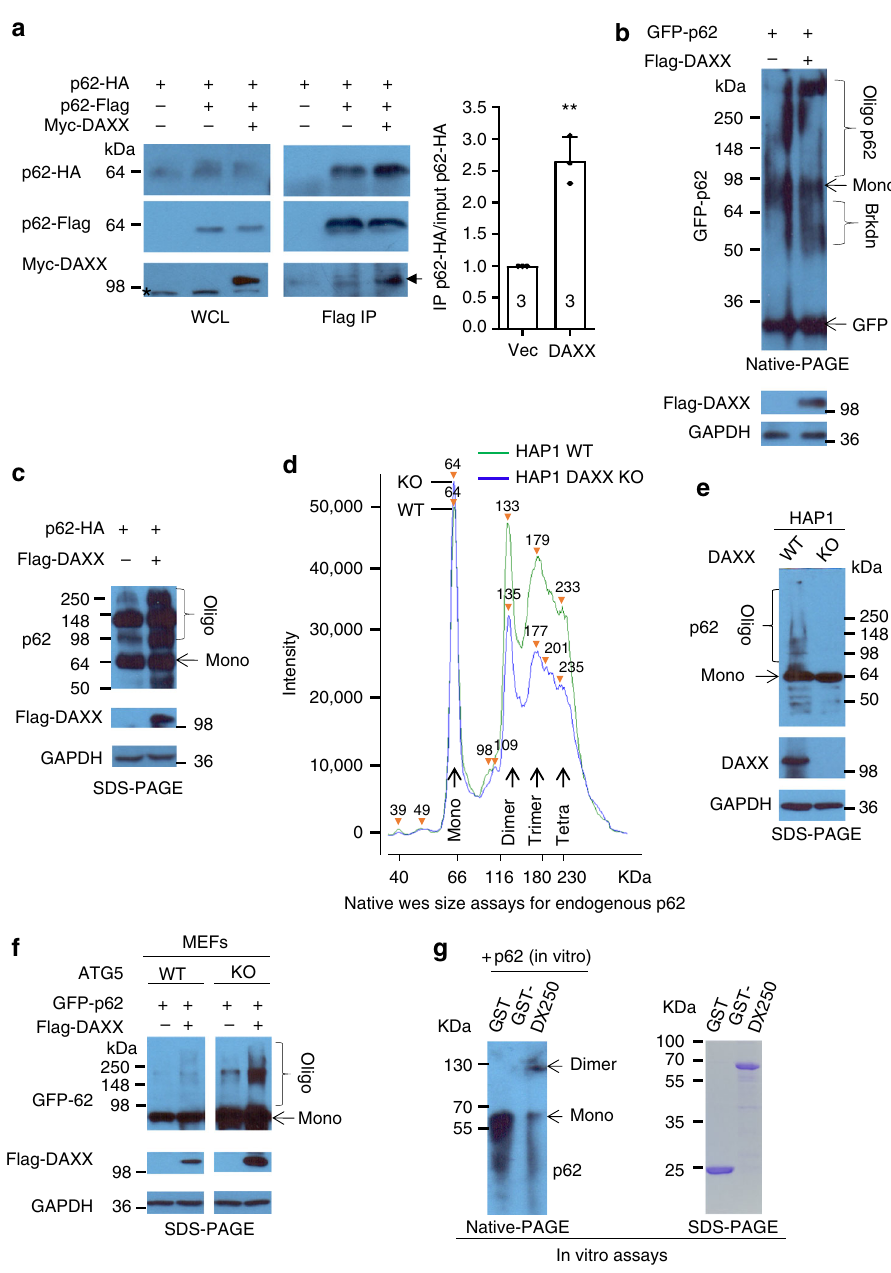
Fig. 5 DAXX promotes p62 oligomerisation. a p62-HA/vector, p62-HA/p62-Flag/vector or p62-HA/p62-Flag/Myc-DAXX were transfected into HeLa cells. After 20 h, the cells were lysed, and the cell lysates were immunoprecipitated with anti-Flag (M2) agarose beads. The immunoprecipitates and the whole cell lysates (WCL) were probed with anti-HA and anti-Flag. * denotes non-speci fi c bands. Arrow marks Myc-DAXX. The ratios of immunoprecipitated p62-HA and input p62-HA were computed (the ratios in controls are set as 1). Statistical analysis was performed with unpaired two- tailed T-tests. Data are shown as mean ± sd. n = 3 independent experiments. ** P = 0.0083. b GFP-p62/vector or GFP-p62/Flag-DAXX were transfected into HeLa cells. After 20 h, the cells were lysed. The cell lysates were subjected to native PAGE, and probed with GFP antibody. The cell lysates were also resolved by SDS-PAGE and probed with anti-Flag and anti-GAPDH. Brkdn: breakdown products; Oligo: oligomers; Mono: monomers. c p62-HA/vector or p62-HA/Flag-DAXX were transfected into HeLa cells. The cell lysates were subjected to SDS-PAGE, and subsequently probed with anti-p62, anti-Flag and anti-GAPDH. d WT HAP1 or DAXX KO HAP1 cells were lysed, and the cell lysates were subjected to native Wes size assays with anti-p62 antibody (1:100 dilution) in native conditions (see Methods section for more details). e HAP1 WT or HAP1 DAXX KO cells were lysed, and the cell lysates were subjected to SDS-PAGE and probed with anti-p62, anti-DAXX and anti-GAPDH. f GFP-p62/vector or GFP-p62/Flag-DAXX were transfected into Atg5 WT or KO MEFs. The cells were lysed and the cell lysates were subjected to SDS-PAGE, and probed with anti-GFP, anti-Flag and anti-GAPDH. g In vitro-translated p62 was incubated with recombinant GST or GST-DAXX 1-250aa (see Methods). The incubated mixtures were subjected to native electrophoresis